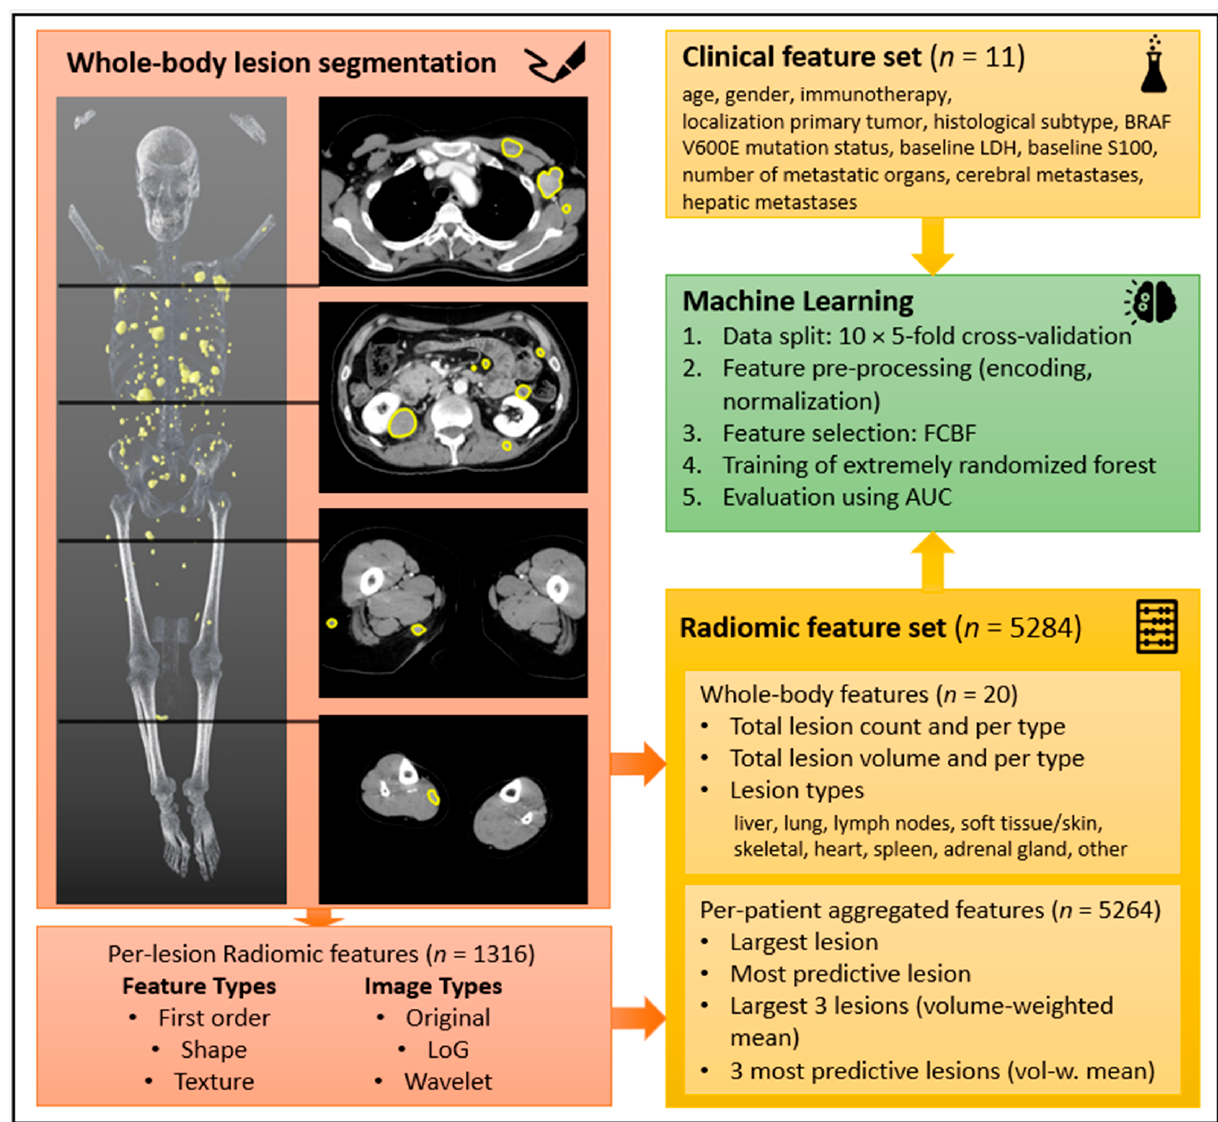
Figure 3. Schematic feature extraction and machine-learning workflow: Top left—3D reformatted model of all segmented metastases (yellow) and examples of 2D segmentation process in axial reformatted CT slices in portal-venous contrast-medium phase; bottom left—radiomic feature types; top right—clinical feature set; bottom right—radiomic feature set; middle right—overview of machine-learning process. Abbreviations: AUC—area under the curve; BRAF—v-Raf murine sarcoma viral oncogene homolog B1; FCBF—fast correlation based filter; LDH—lactate dehydrogenase; LoG—Laplacian of Gaussian.